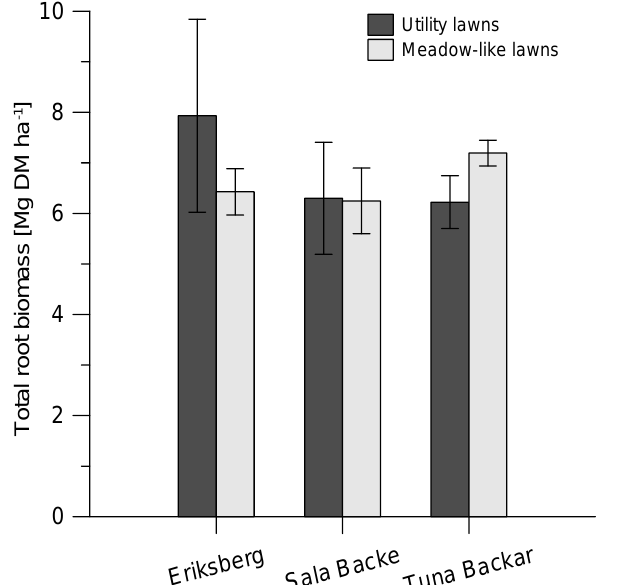
Figure 3. Bar plot showing total root biomass at 0–10cm depth for the two different lawn types at the study sites in Uppsala. Error bars indicate standard